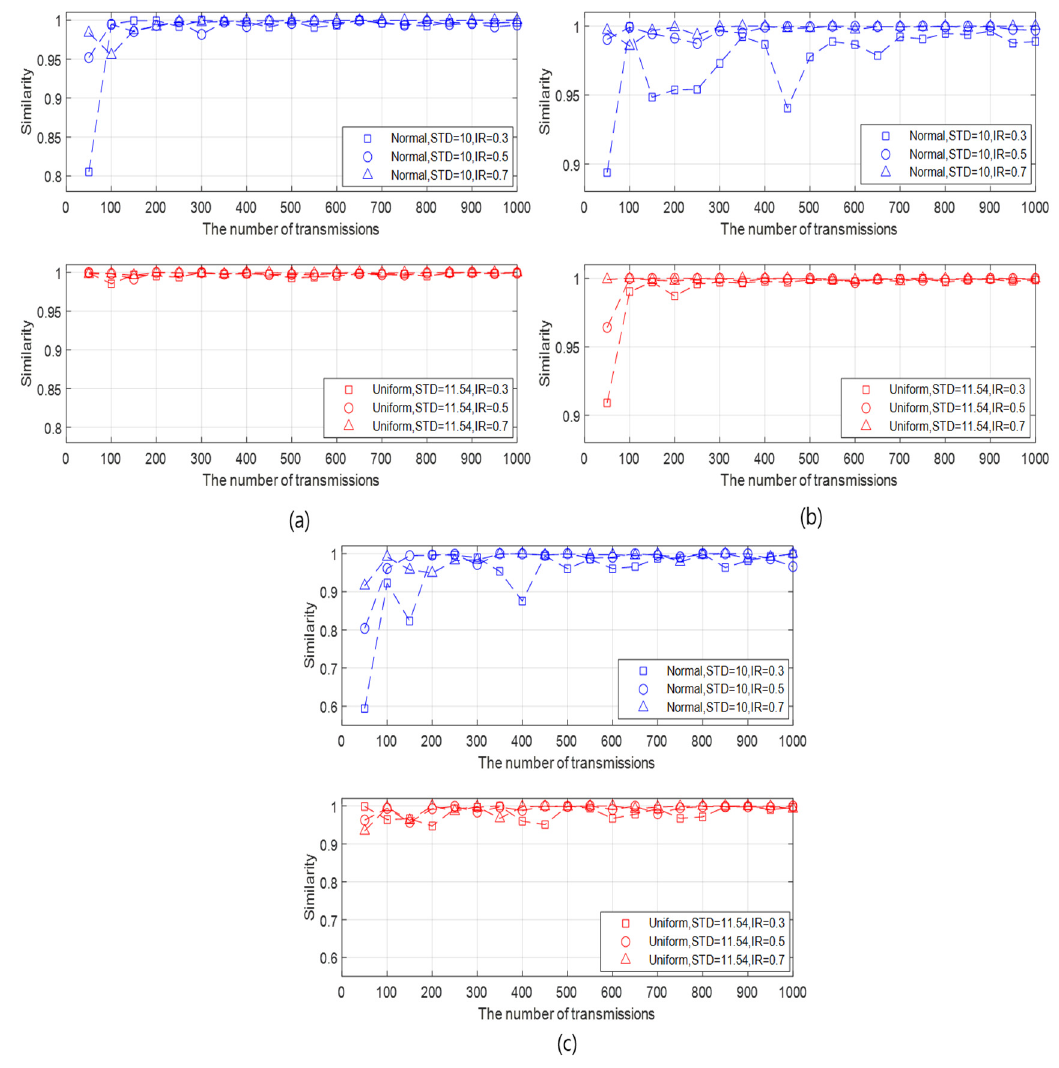
Figure 5. Similarities according to the number of transmissions for different data type, initialization rate, and the BER when the STD of the generated data with normal distribution and that with uniform distribution are respectively 10 and 11.54, and the number of slave nodes is 30. ( a ) BER = 5 × 10 − 3 , ( b ) BER = 10 − 3 , and ( c ) BER = 10 − 2 .